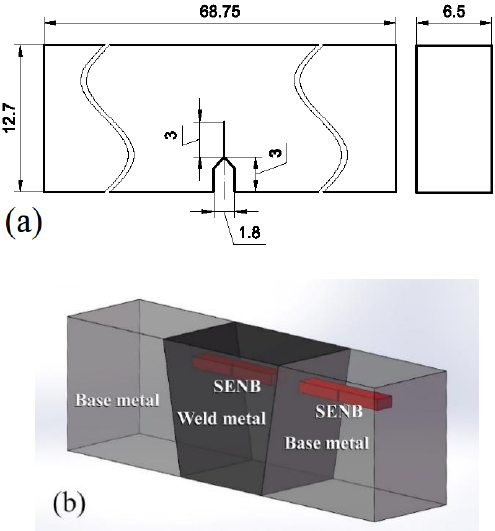
Figure 2. Single edge notched-bend (SENB) specimens: ( a ) Dimension of BM and WM three points specimen (units: mm); ( b ) Schematic of positions of the SENB specimens’ sampling.